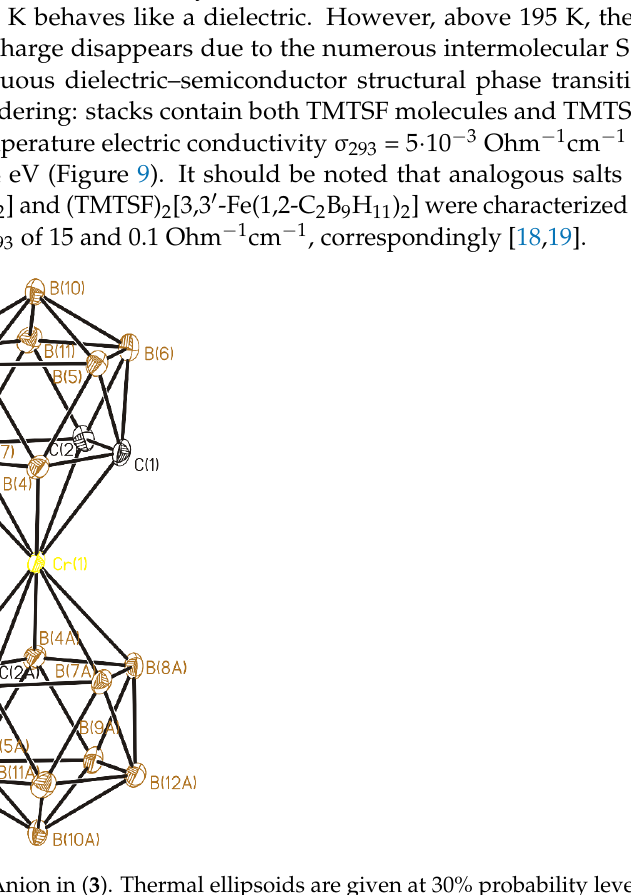
Figure 7. Crystal packing fragment of ( 3 ). A view along the a axis. The unit cell is outlined. H at- oms are omitted for clarity. The Cr-C and Cr-B bond lengths are 2.175(7)–2.176(7) and 2.226(8)–2.277(8) Å, corre- spondingly. The distances from the chromium atom to the C 2 B 3 faces of the dicarbollide ligands are equal to 1.68 Å, and the dicarbollide ligands in the [3,3 ′ -Cr(1,2-C 2 B 9 H 10 ) 2 ] − an- ion are turned relative to each other by 180°, forming the transoid conformation. The C 2 B 3 faces are parallel to each other by the symmetry conditions.